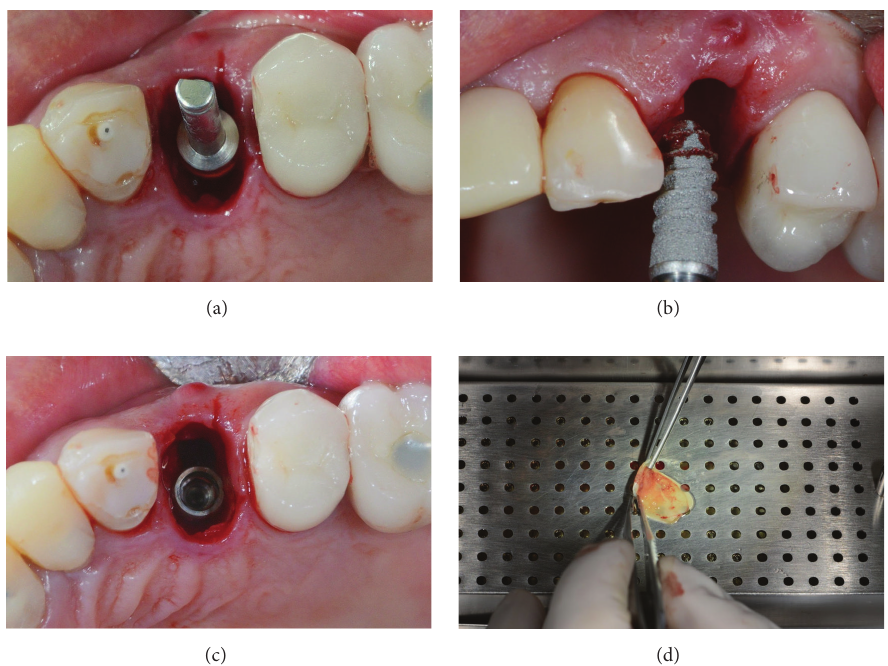
Figure 2: Placement of a single 3DP/AM titanium dental implant in a postextraction socket of the posterior maxilla: surgical phases. (a) Preparation of the implant site. (b) Placement of the 3DP/AM porous implant in the postextraction socket. (c) The implant in position. (d) Preparation of the biological membrane-platelet rich in growth factors (PRGF).